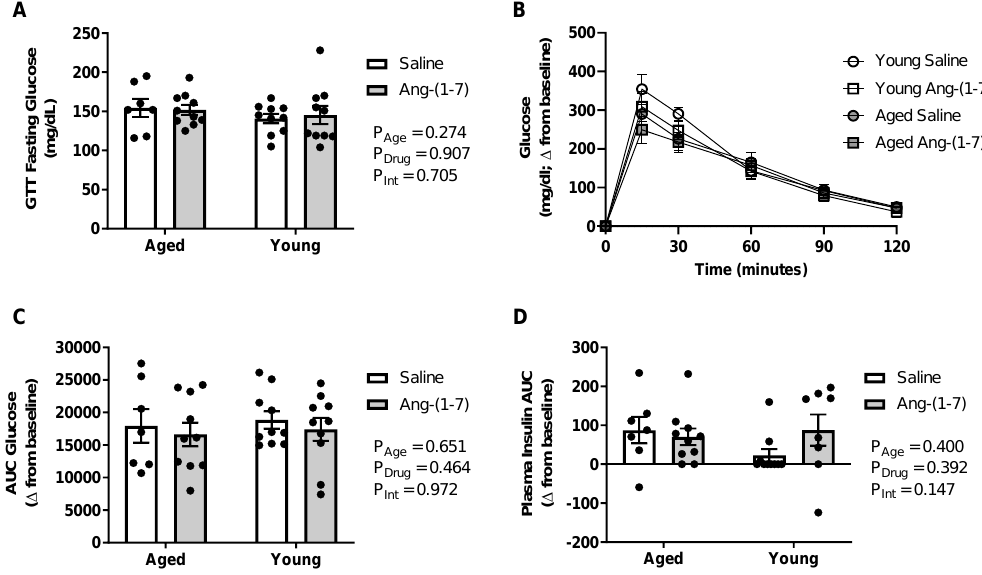
Figure 2. Glucose tolerance was not affected by aging or chronic angiotensin (Ang)-(1-7) treatment ( n = 8–10 / group). ( A ), Bar charts showing there was no impact of aging or Ang-(1-7) treatment on circulating glucose levels measured after an overnight fasting period. ( B ), Raw data curve showing changes in blood glucose levels from baseline over a 120-min period following exogenous dextrose administration in young adult and aged mice. ( C ), Glucose data summarized as an AUC, with a more positive number indicating higher levels of glucose remaining in the blood over time or glucose intolerance. There was no e ff ect of aging or Ang-(1-7) treatment on glucose tolerance. ( D ), Insulin data summarized as an AUC, with a more positive number indicating increased insulin secretion. There was no e ff ect of aging or Ang-(1-7) treatment on glucose-stimulated endogenous insulin secretion. Data are mean ± SEM and were analyzed by two-way ANOVA for main e ff ects of age ( P Age ) and Ang-(1-7) versus saline treatment ( P Drug ) as well as their interaction (P Int ), with Tukey post-hoc pairwise comparisons with correction for multiple comparisons.